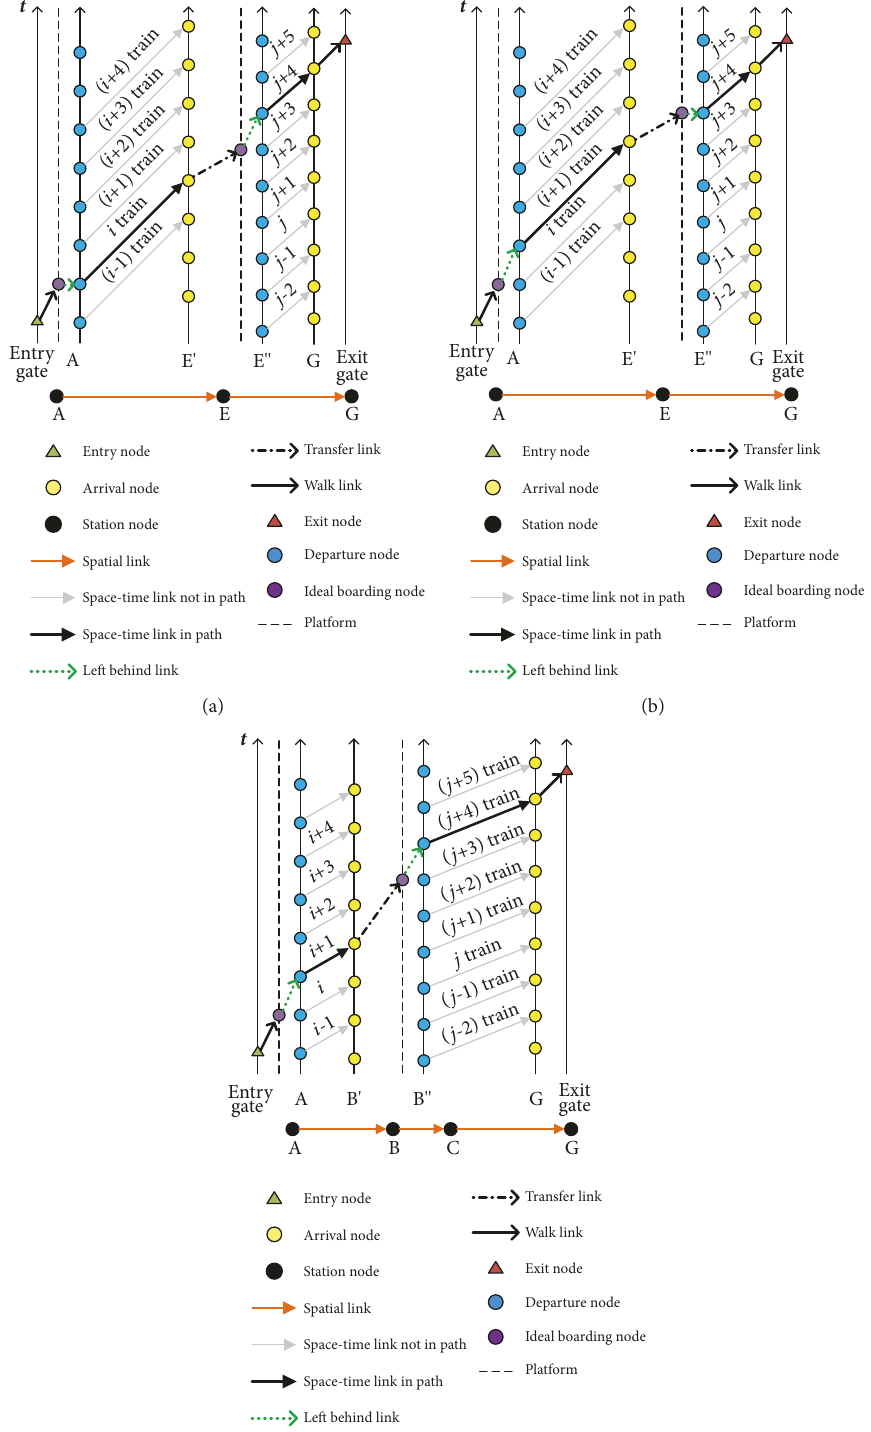
Figure 2: Feasible space-time-sequence